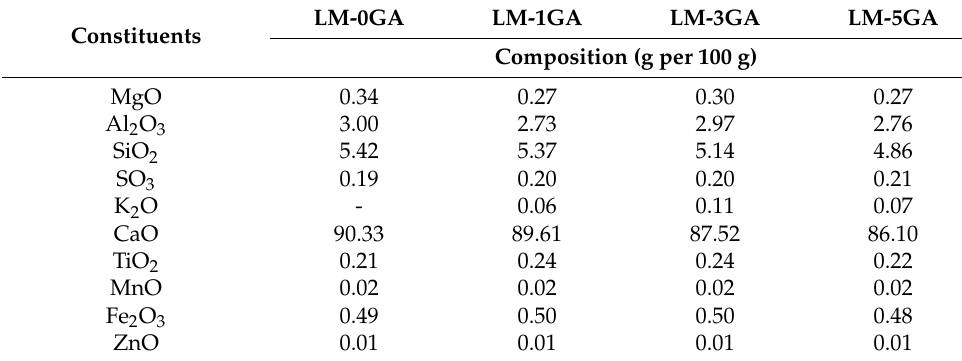
Table 2. Chemical composition of tested mixtures of paste.